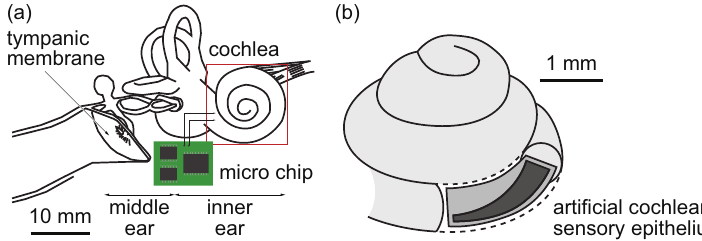
Figure A1. ( a ) Schematic of the micro chip at the mastoid cavity of the middle ear which performs the feedback control. ( b ) Schematic of possible configuration in the insertion of an artificial cochlear sensory epithelium into the